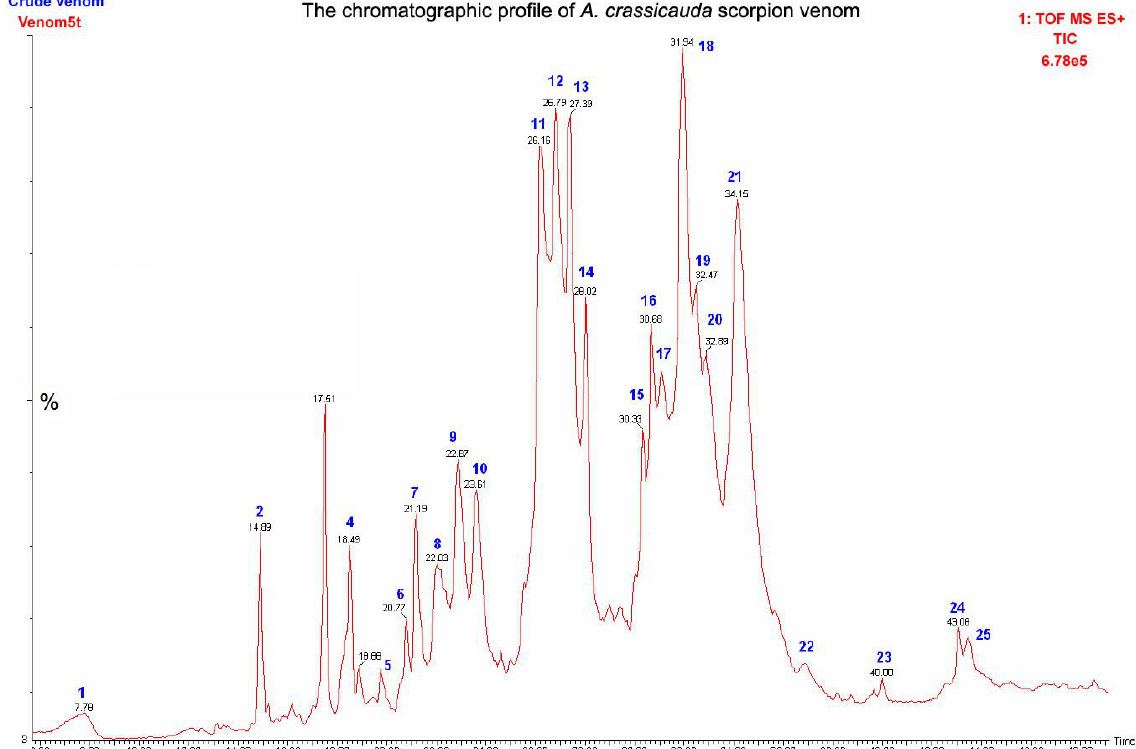
Figure 3. Mass spectrum of total ion chromatogram and UV trace of the crude venom. Total ion chromatography of A. crassicauda venom between 6 and 49 minutes, with peak